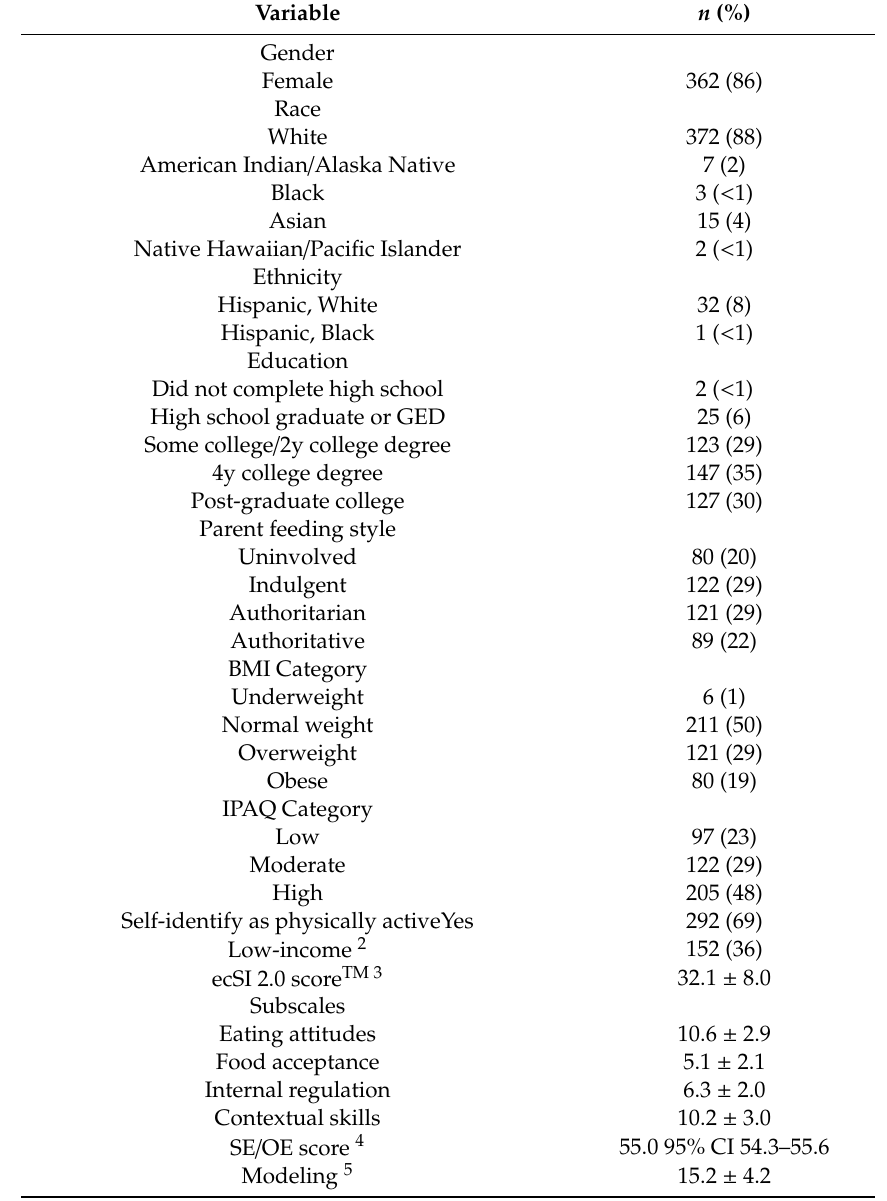
Table 1. Characteristics of parents of 4th grade participants in Fuel for Fun 1